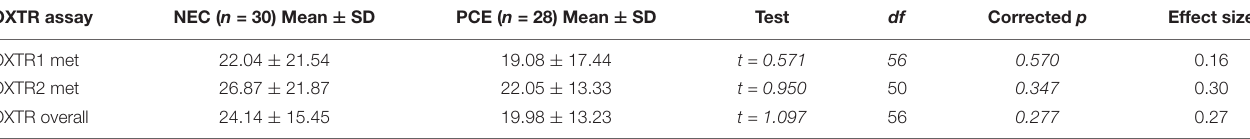
TABLE 3 | DNA methylation levels in OXTR exon III in the umbilical cord blood of the prenatal cocaine-exposed and non-exposed newborns. OXTR assay